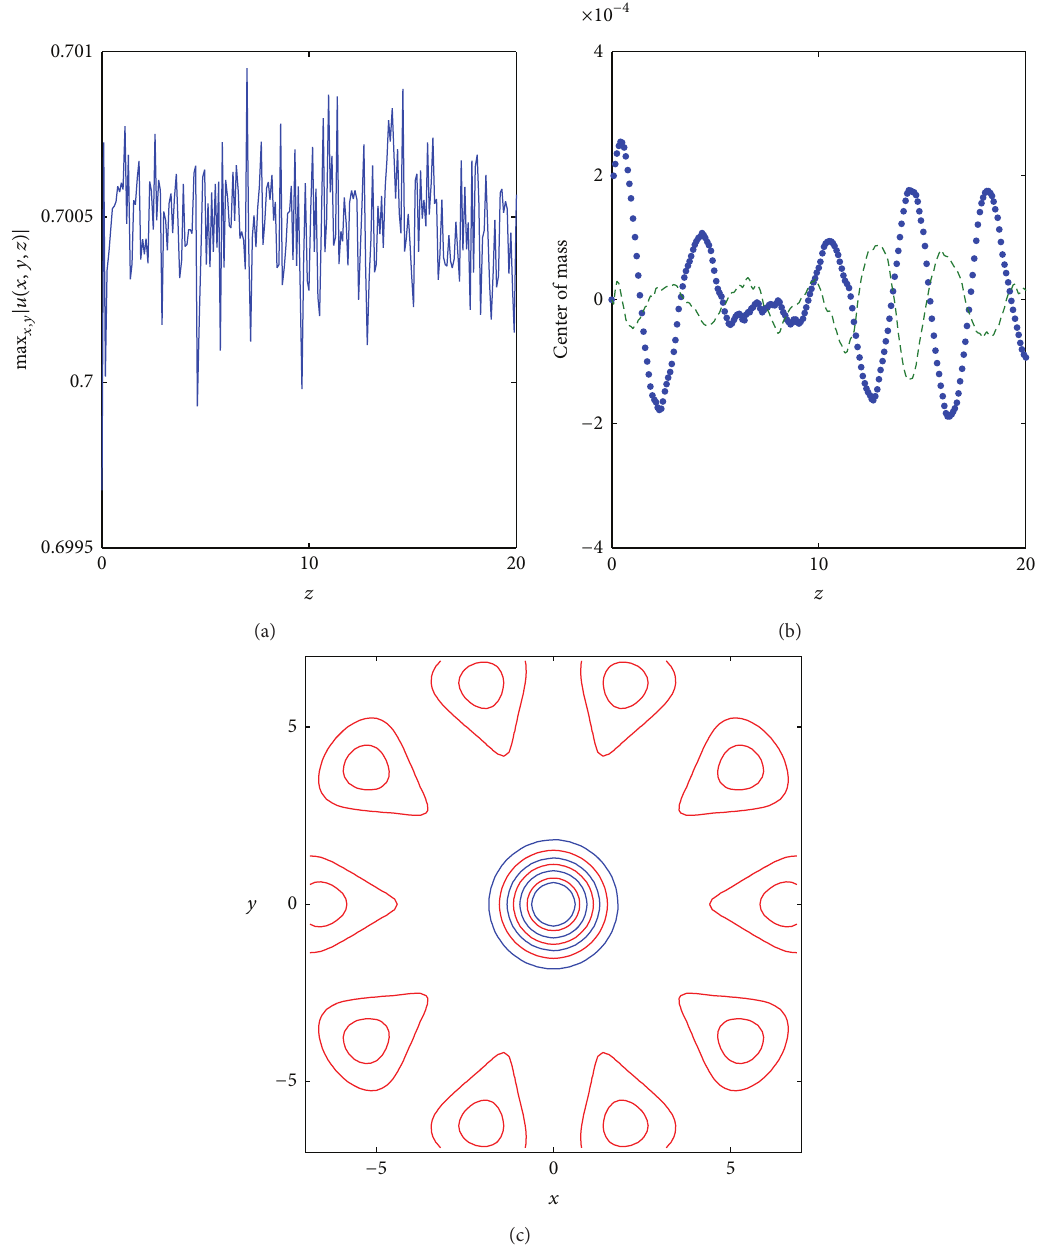
Figure 17: Nonlinear evolution of the lattice soliton corresponding to the first renormalization factor situated at the Penrose potential with 𝜇 = 1.5 for the self-focusing cubic and the self-defocusing quintic model. (a) Peak amplitude of the lattice soliton as a function of the propagation distance. The initial condition is taken as the lattice soliton corresponding to the first renormalization factor with a 0.01 noise in the amplitude and phase. (b) Center of mass evolution in 𝑥 and 𝑦 coordinates. (c) Cross section along the diagonal axis of the fundamental soliton superimposed on the Penrose potential after the propagation ( 𝑧 = 20